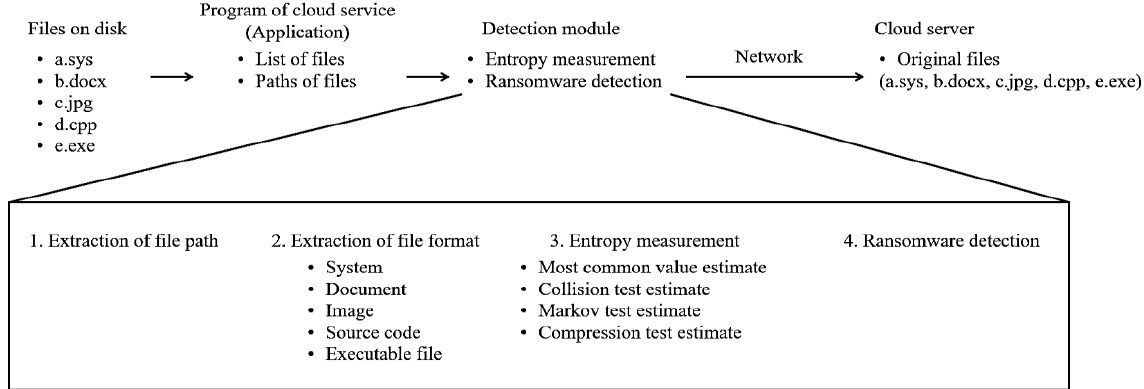
Figure 1. The proposed detection